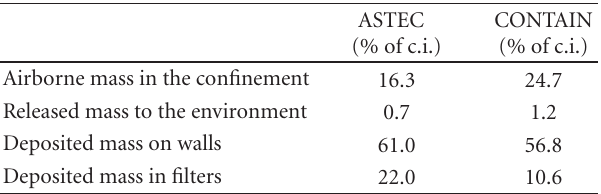
Figure 11: Aerosol concentration evolution in the main confine- ment compartments for the SB sequence. Table 2: Aerosol mass balance for the SB sequence.